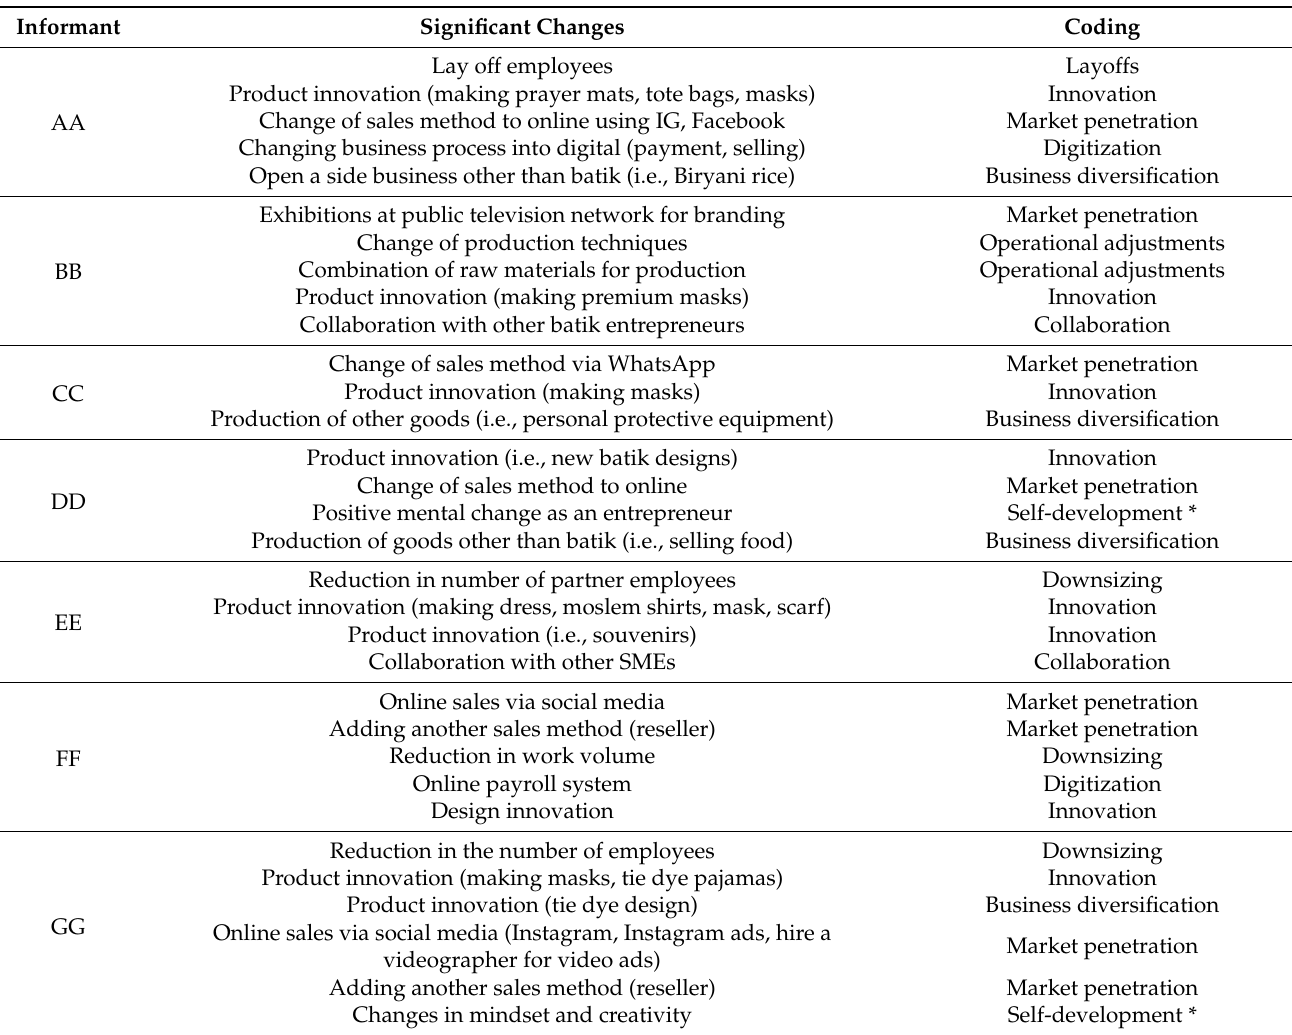
Table 3. Results of the Most Significant